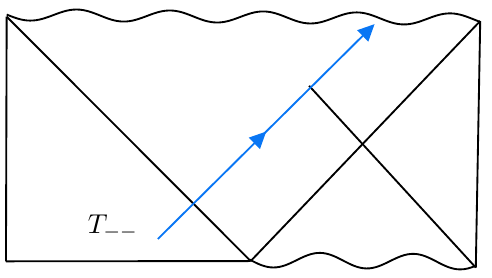
Figure 2 . A shockwave of appropriate strength causes the spacelike singularity originally hidden behind the black hole horizon to stretch outwards covering an entire spacelike